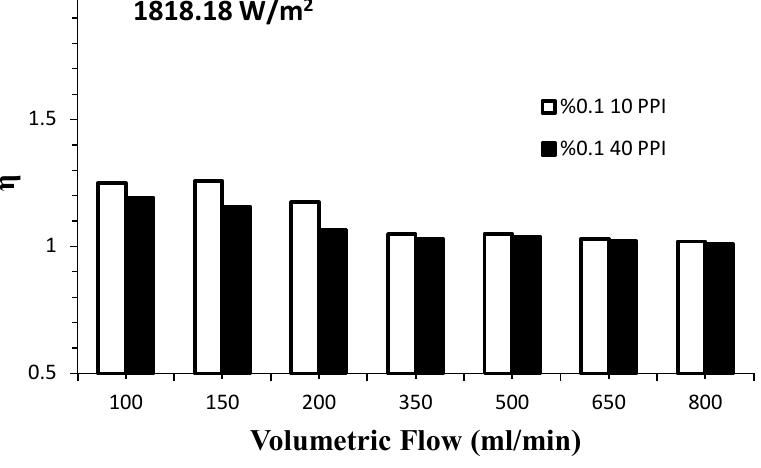
Figure 13. Thermal performance efficiency of 10 PPI and 40 PPI PHSs with nanofluid.